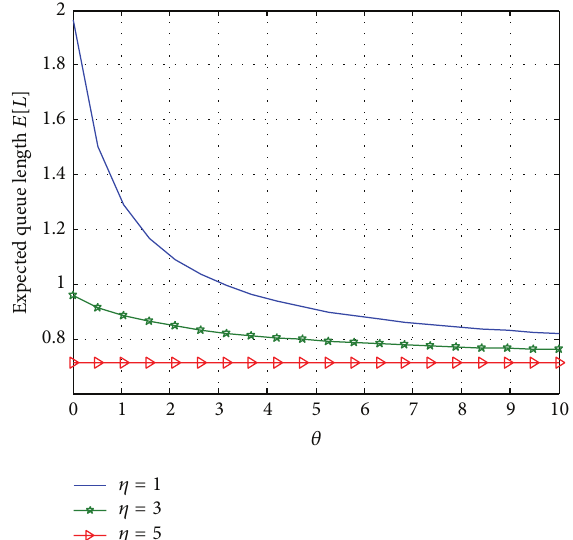
Figure 2: The effect of 𝜃 on 𝐸[𝐿] for different values of 𝜂 .